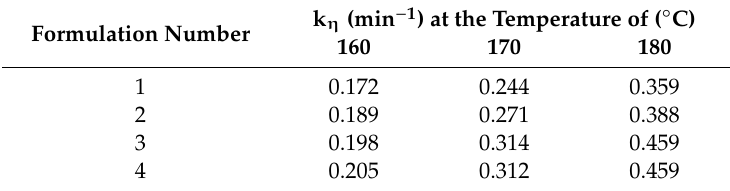
Table2. Valuesofviscosityincreaserateconstants(k η )forformulations1–4atdifferentcuringtemperatures. Formulation